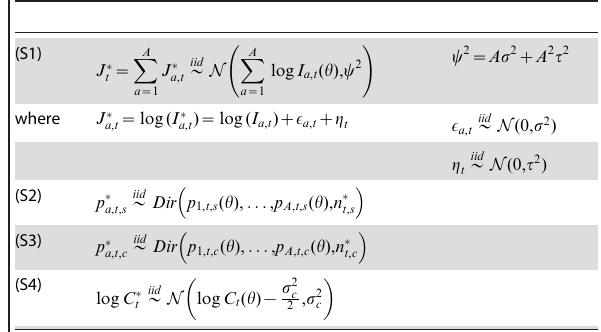
Table 3. Deterministic and stochastic processes used in SIMCAB estimation and projection models, respectively. iid: independent and identically distributed; * : distributed as. B ( n , p ) : binomial distribution with probability parameter p .